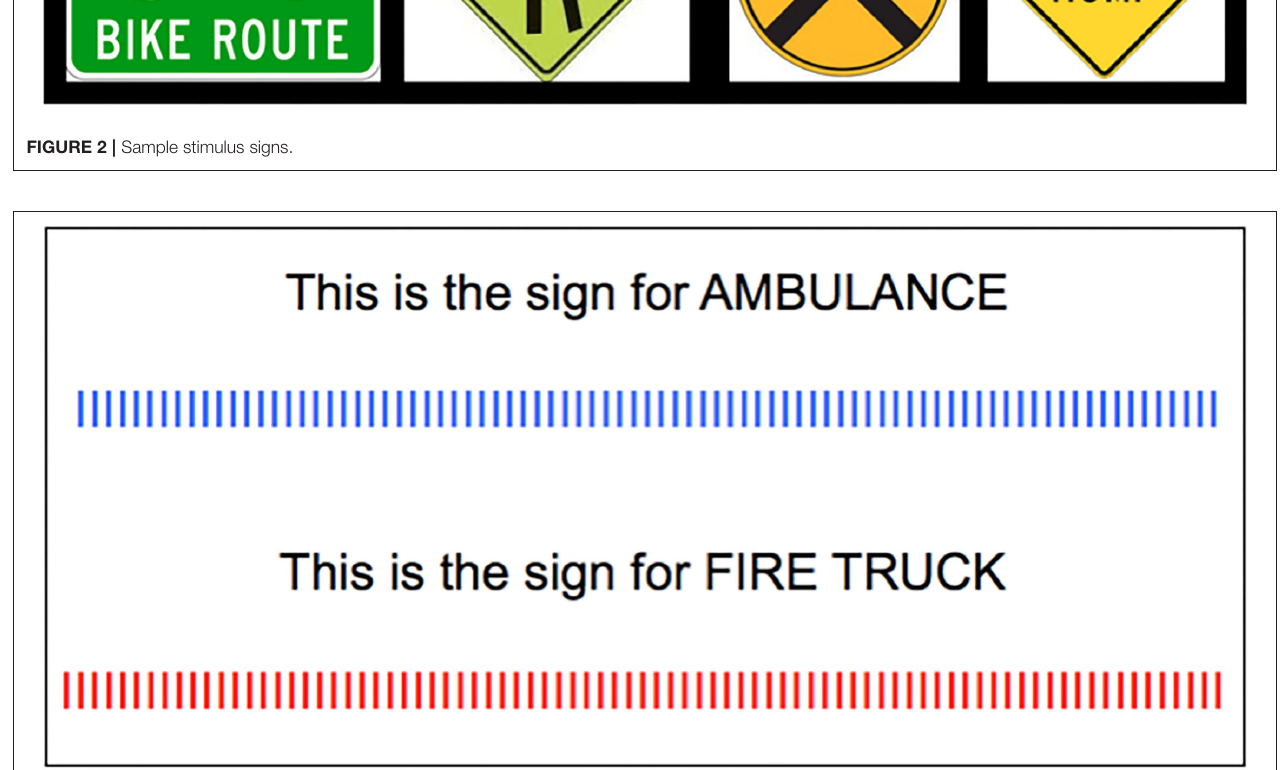
FIGURE 3 | The manner in which subjects were presented with the Ambulance and Fire Truck signs. The Ambulance sign (presented in blue [top]) and the Fire Truck sign (presented in red [bottom]).